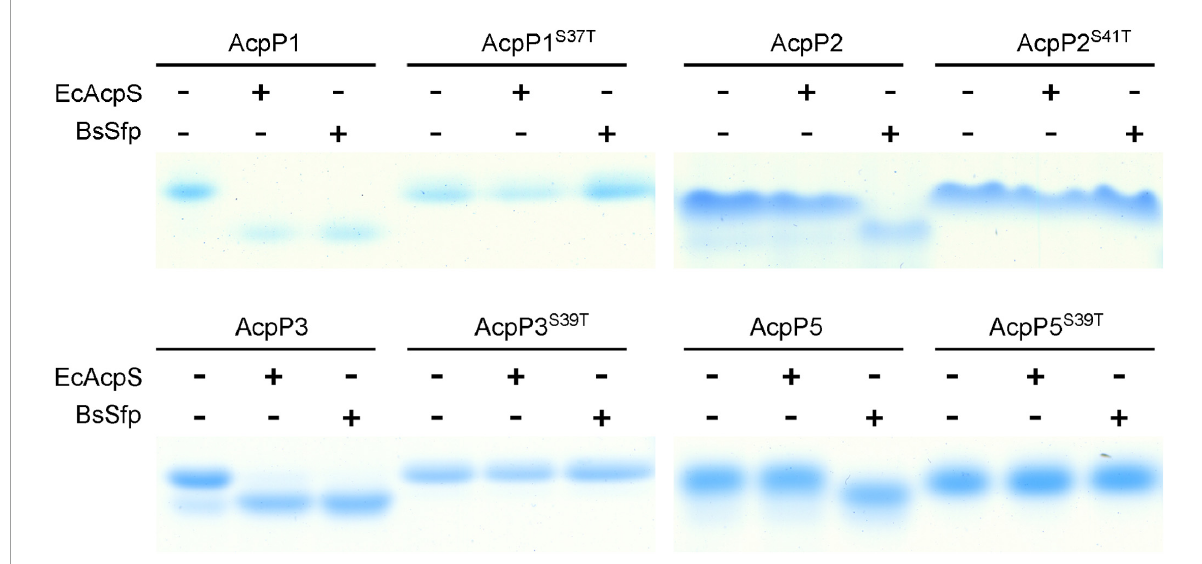
FIGURE2 Four R . solanacearum ACPs were phosphopantetheinylated in vitro . The reaction mixture contained ACP, CoA, and E . coli AcpS or B . subtilis Sfp in AcpS reaction buffer. The apo -ACPs tested as the reaction substrate are given above each